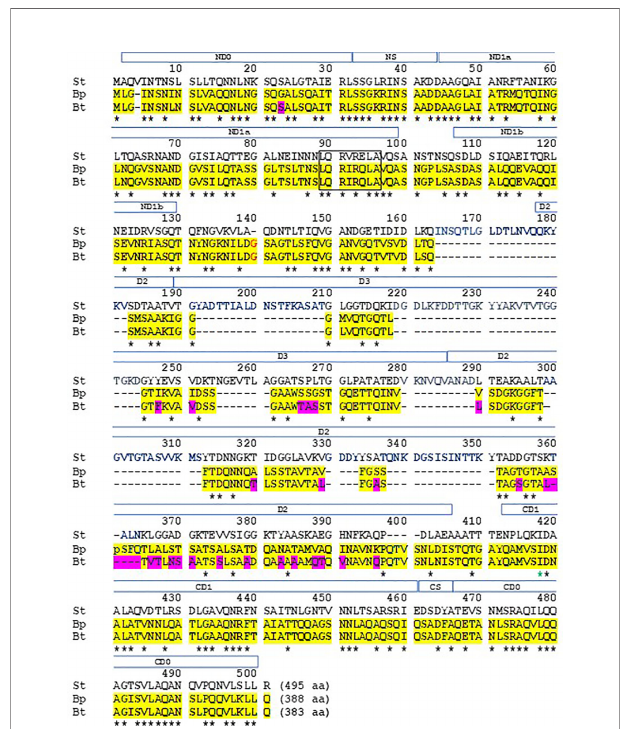
FIGURE 9 | Alignment of amino acid sequences of St LT2, Bp K96243, and Bt E264 FliC reveals common sequences required for folding and TLR5 activation. The amino acid sequences of FliC (495 aa, 388 aa, and 383 aa, respectively) from the three microorganisms were aligned for optimal identity (Papadopoulos and Agarwala, 2007). The amino acid sequences of FliC of Bp K96243 and Bt E264 are highlighted in yellow with differences between the two sequences highlighted in red. The asterisk below the three sequences represent identical amino acids for all three FliCs. The dashes are spaces between amino acids for missing amino acids in the three FliCs. The amino acids within the square (89 − 96 aa) have been reported to be required for recognition by TLR5 (Smith et al., 2003; Andersen-Nissen et al., 2005). The open boxed region above the sequences represent structural domains (D0, D1, D2, and D3) of FliC that are involved in tertiary formation of the molecule and are found in both N- and C-terminal regions (regions preceded by N or C, respectively) of the molecule. (Smith et al., 2003; Yonekura et al., 2003; Andersen-Nissen et al., 2005; Yoon et al., 2012). Within the domains there are subregions, and between D0 and D1 there is a small “ spoke ” (S) region at both N-terminal (NS) and C-terminal regions (CS) (Smith et al., 2003; Yonekura et al., 2003; Andersen-Nissen et al., 2007; Yoon et al.,